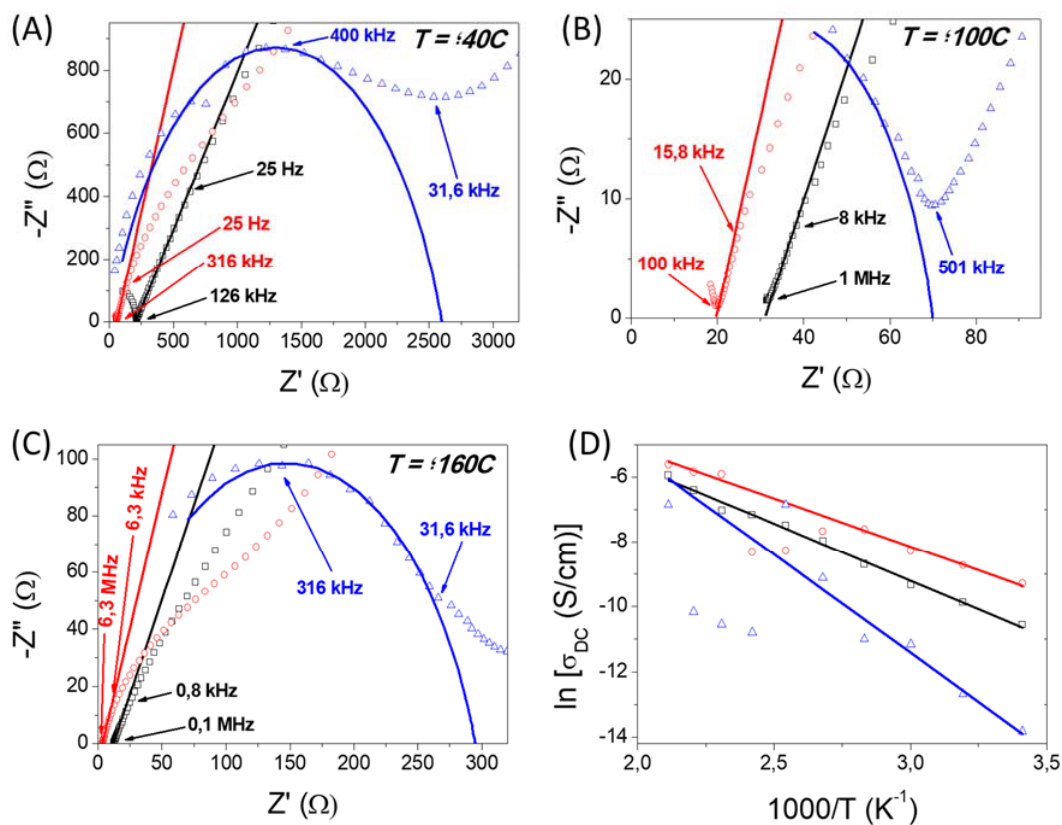
Figure 8. ( A – C ) Cole-Cole plots of the complex impedance measured in wet conditions at di ff erent temperatures for the samples: ( ) PBI@SiNF, ( (cid:13) ) PBI@SiNF–NH 2 and ( ∆ ) PBI@SiNF–SO 3 H. ( D ) The (cid:50) solid line represents the fitting to the equivalent circuit models as shown in Figure